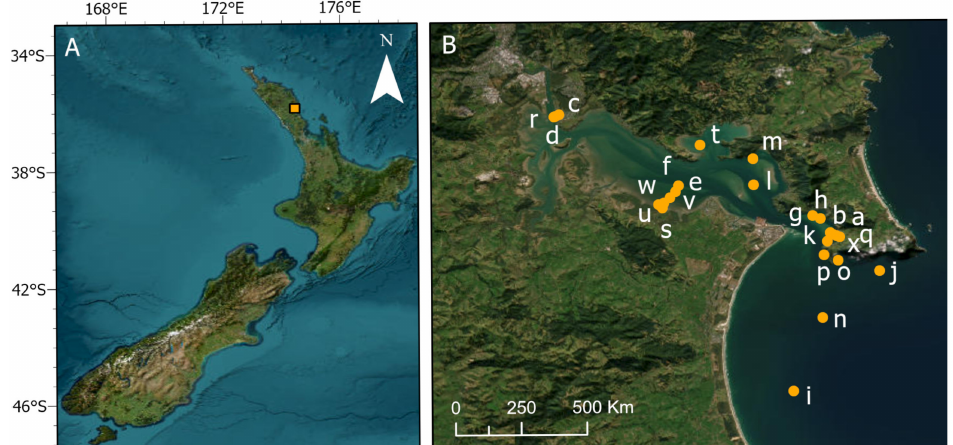
Figure 1. ( A ) Location of the study estuary situated on the North Island of New Zealand and ( B ) locations of the 24 sites within Whang¯arei Harbour and adjacent Bream